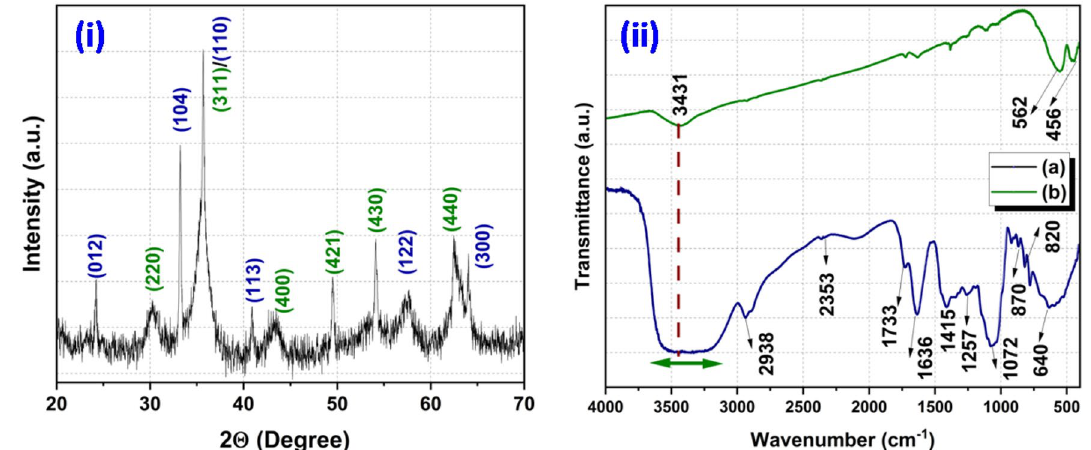
Figure 1. XRD pattern of synthesized product ( i ) and FT-IR spectra of waste pulp extract of Syzygium cumini (a) and Fe